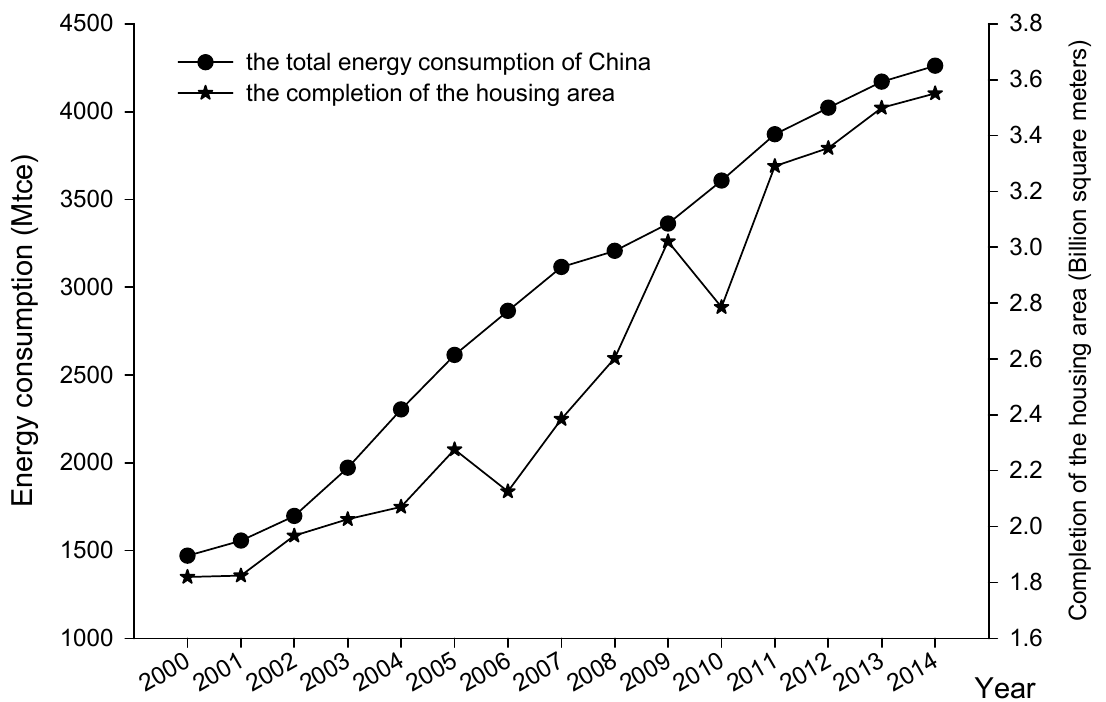
Figure 2. The Energy Consumption and the building completion area in China during